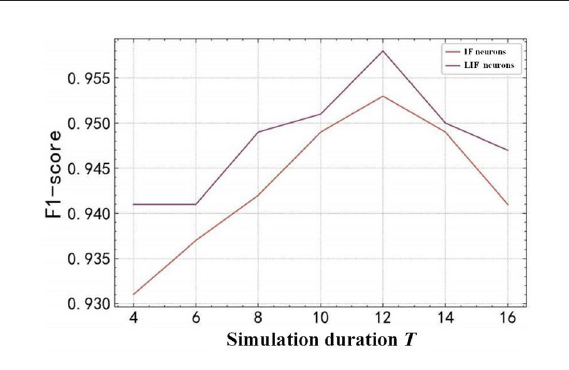
FIGURE10 Comparison of different neuron models and simulation